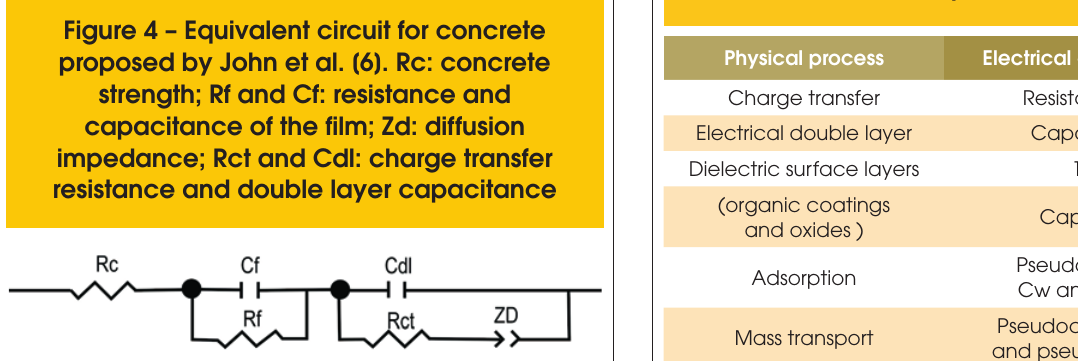
Table 1 – Properties of the components of the composite beam